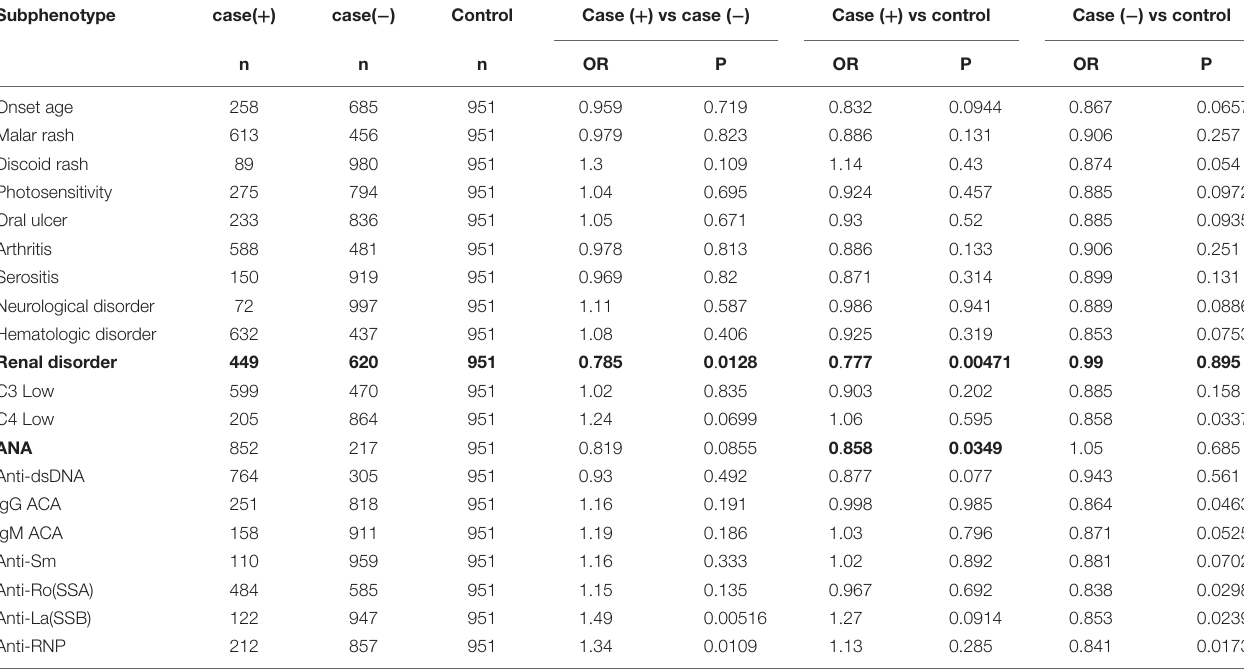
TABLE 2 | Association of IRF3 rs7251 with SLE analyzed by subphenotype stratification.